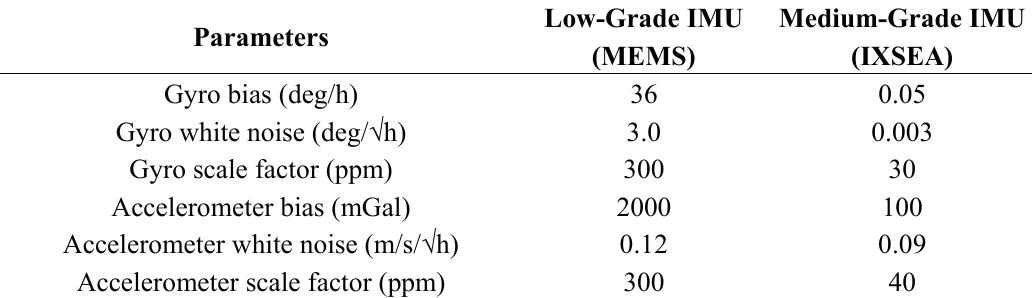
Figure 14. Setup of the simulation testing. Table 2. IMU configuration parameters in the simulator. IXSEA is the model of a typical medium-grade